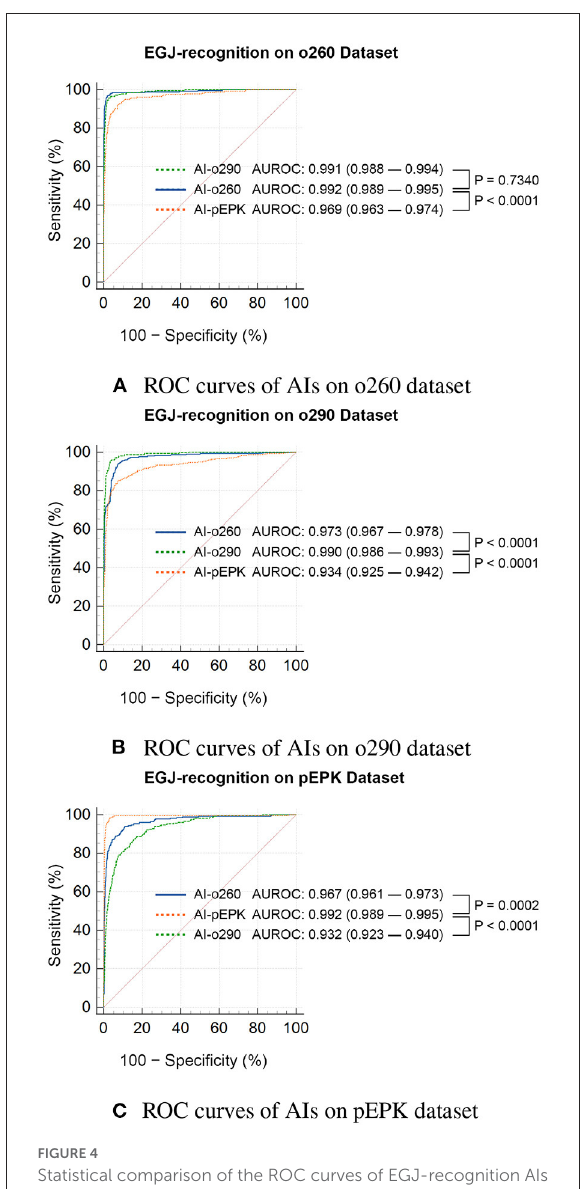
FIGURE4 Statistical comparison of the ROC curves of EGJ-recognition AIs on validation datasets. ROC curves of AIs on (A) o260, (B) o290, and (C) pEPK dataset. EGJ-recognition AIs (AI-o260, AI-o290, and AI-pEPK) trained on a dataset classified by the endoscope model had degraded performance on the validation dataset of other endoscope models. (A) The performance difference between AI-o260 and AI-o290 in this dataset was the only nonsignificant result. (B,C) In the o290 and pEPK dataset, the performance of AIs trained with images of different endoscope models were significantly inferior. o260, Olympus CV-260SL; o290, Olympus CV-290; pEPK, PENTAX EPK-i; AI, artificial intelligence; EGJ, esophagogastric junction; AUROC, area under the receiver operating characteristic